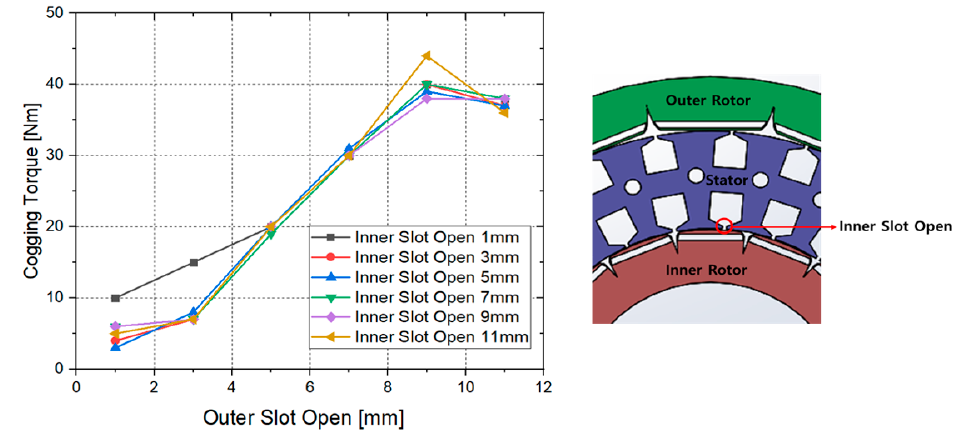
Figure 4. Comparison of cogging torque according to the length of the slot opening.